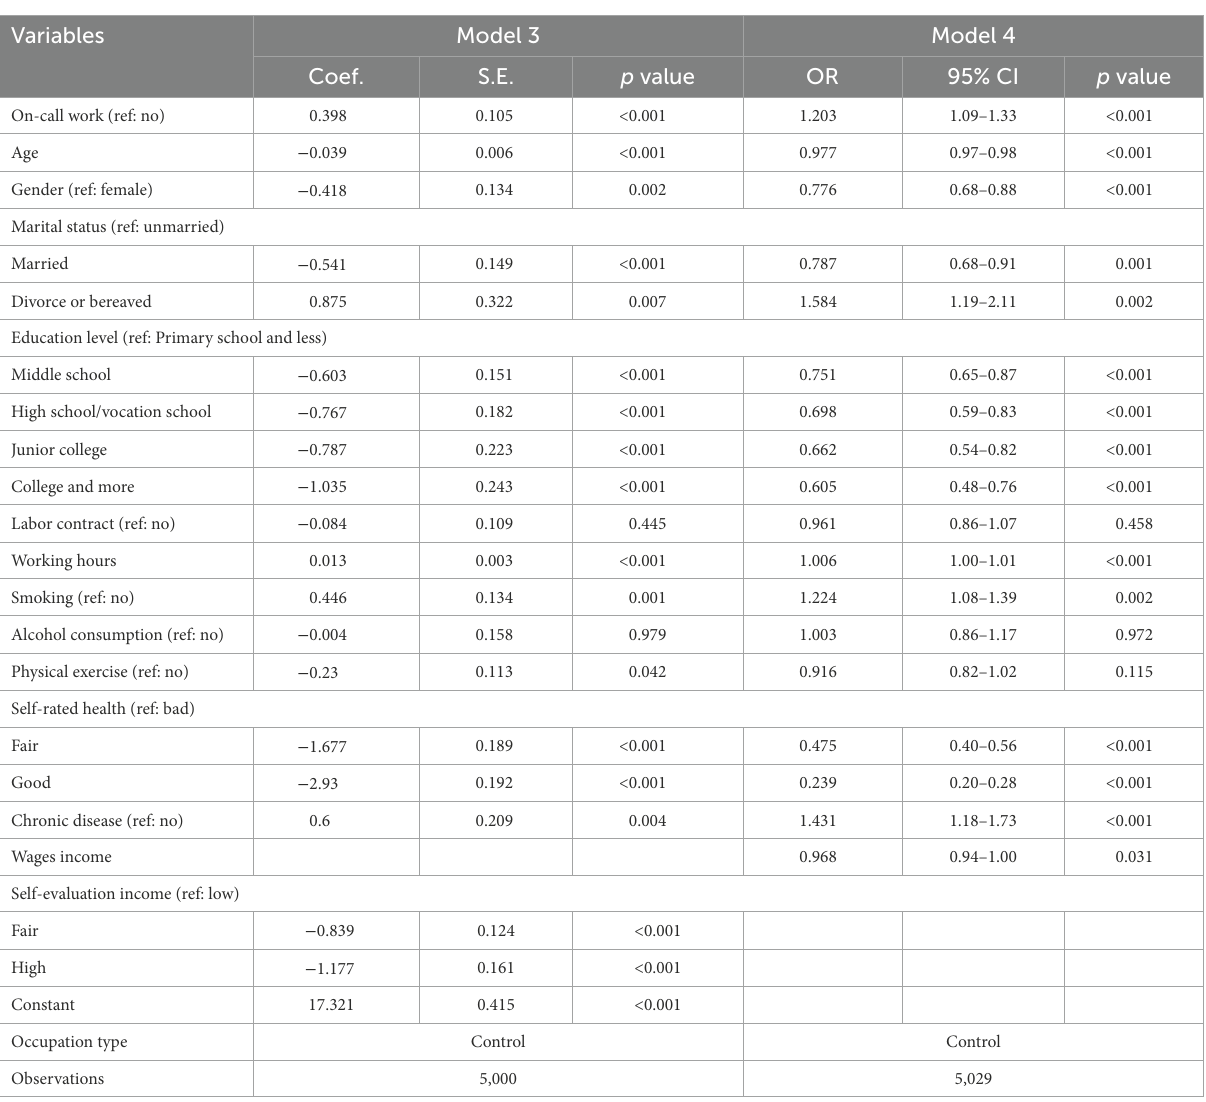
TABLE 4 Robustness test.